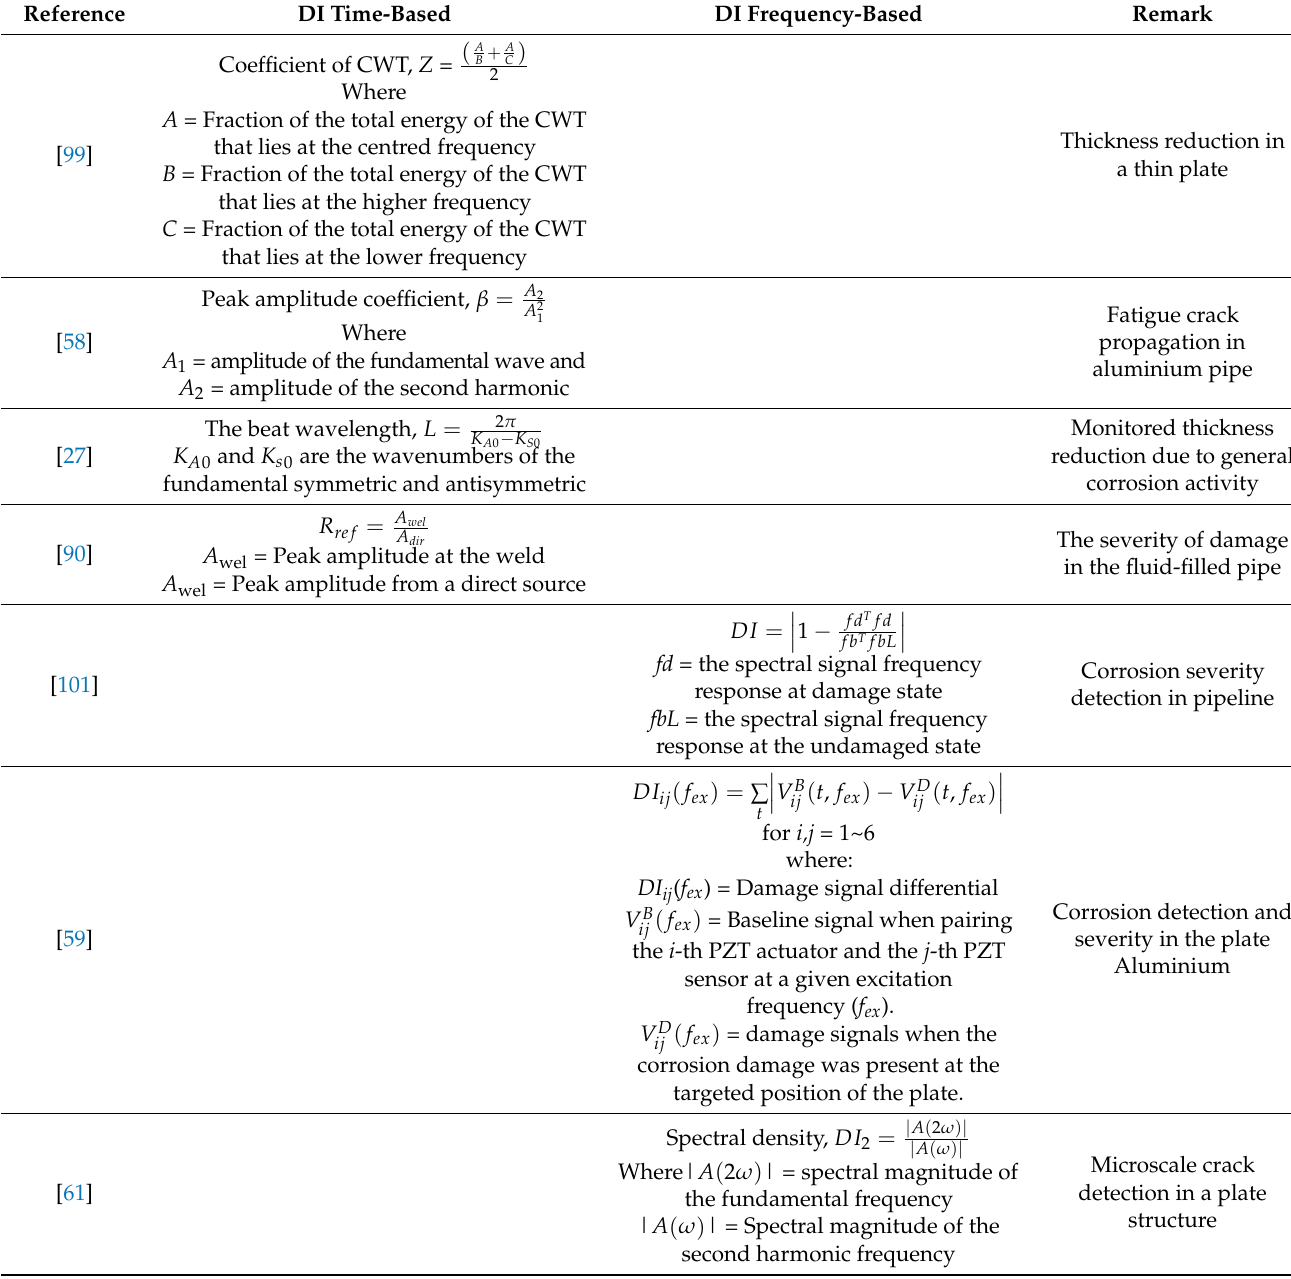
Table 3. Classification of DI according to